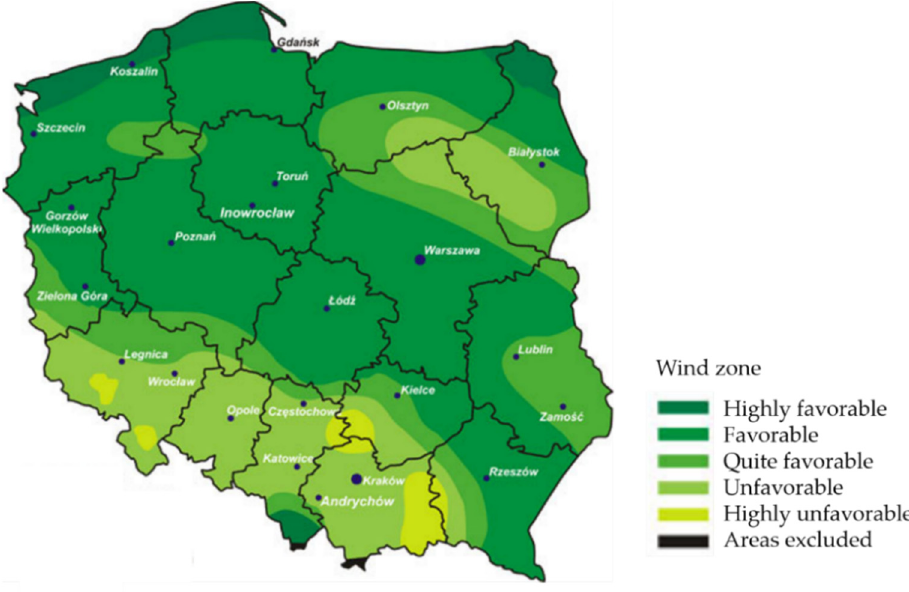
Figure 9. Wind map in Poland